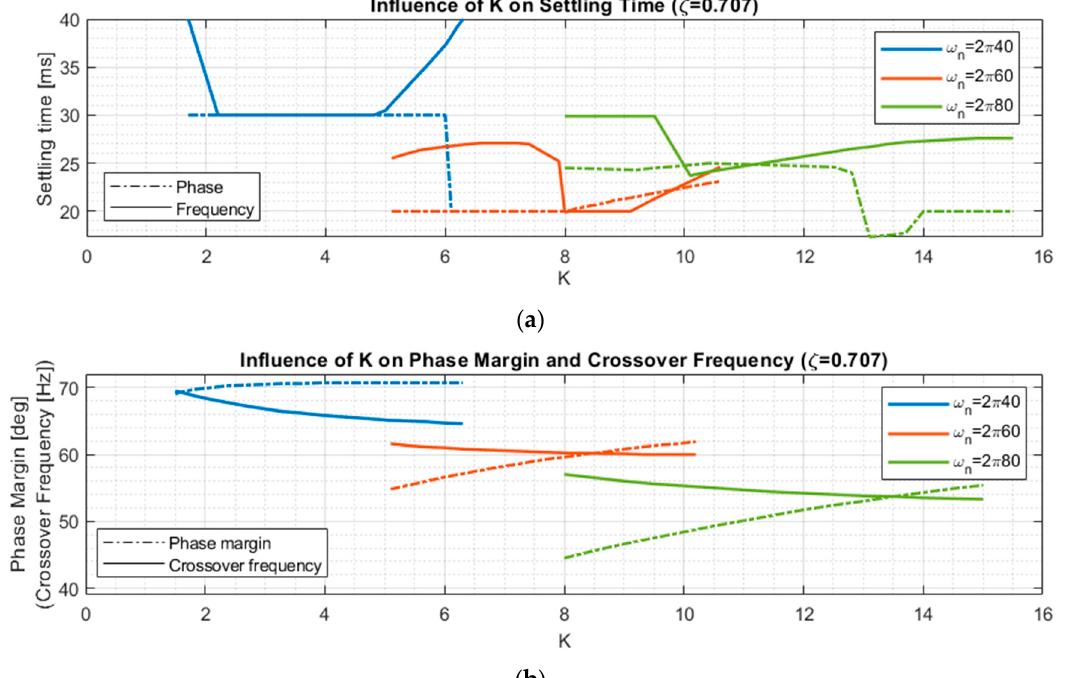
Figure 8. Influence of parameter K on di ff erent aspects of the system for di ff erent PI controller parameters. ( a ) Phase angle and frequency settling time; ( b ) Phase margin and crossover